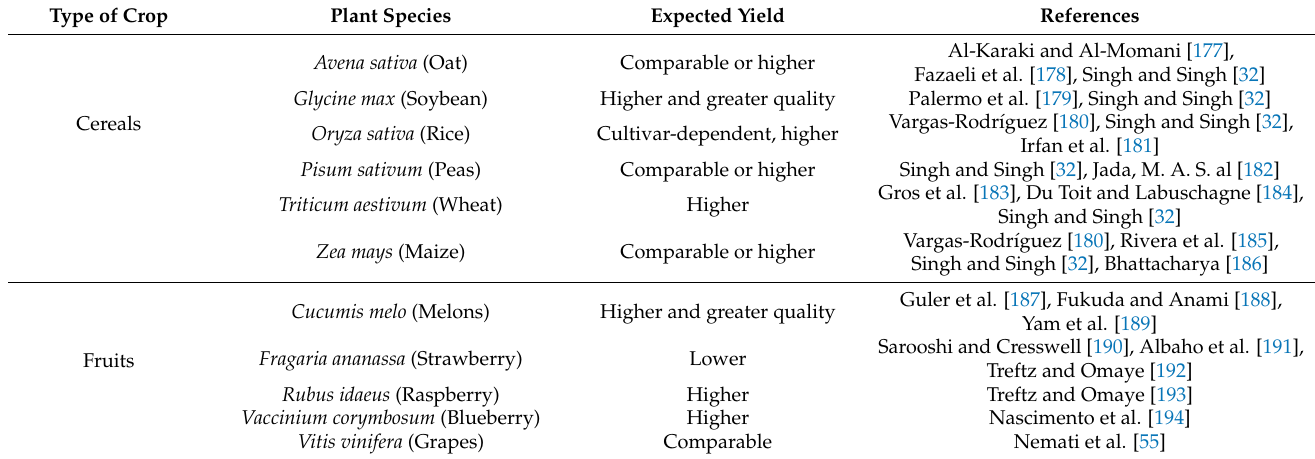
Table A3. List of different plant species that can be cultivated hydroponically. Summarized partly after Hayden [44], Resh [83], Singh and Singh [32], Sardare and Adame [86], Mohammed [43] and Sharma et al.